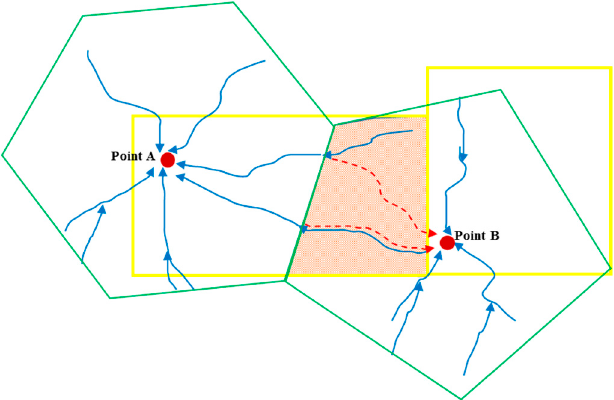
Figure 16. Quantitative indices for Error-FD (Error flow direction).